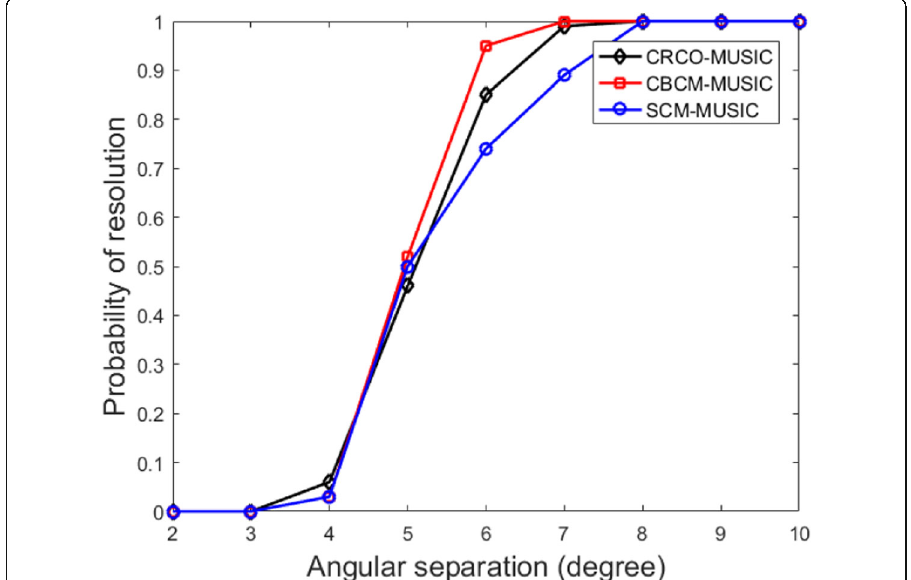
Fig. 20 Probability of resolution against the angular